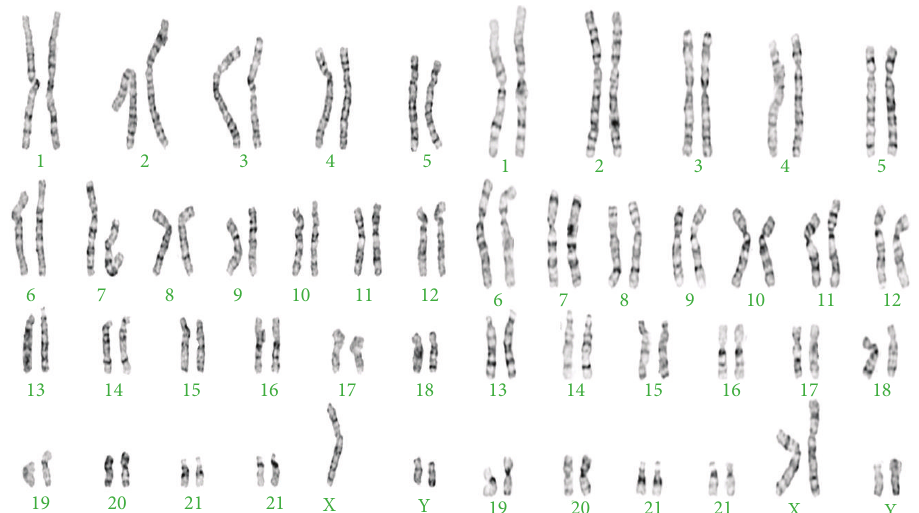
Figure 1: Karyotype of the